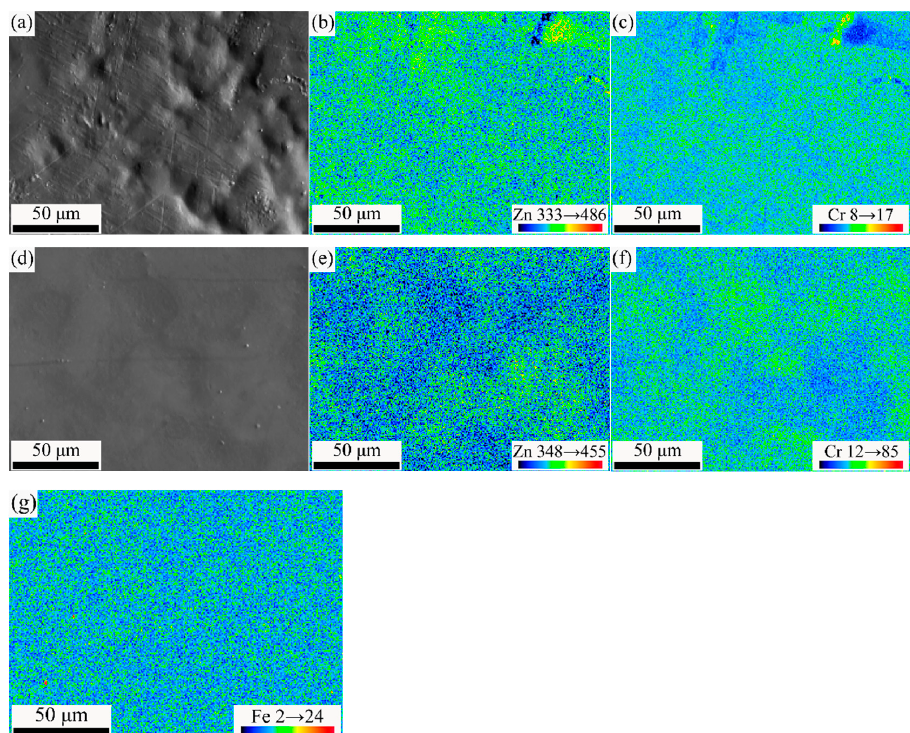
Figure 4. EPMA images with large size of passivated film: ( a – c ) SEM, Zn and Cr mapping of PZC, ( d – g ) SEM, Zn, Cr and Fe mapping of PZFC, respectively.